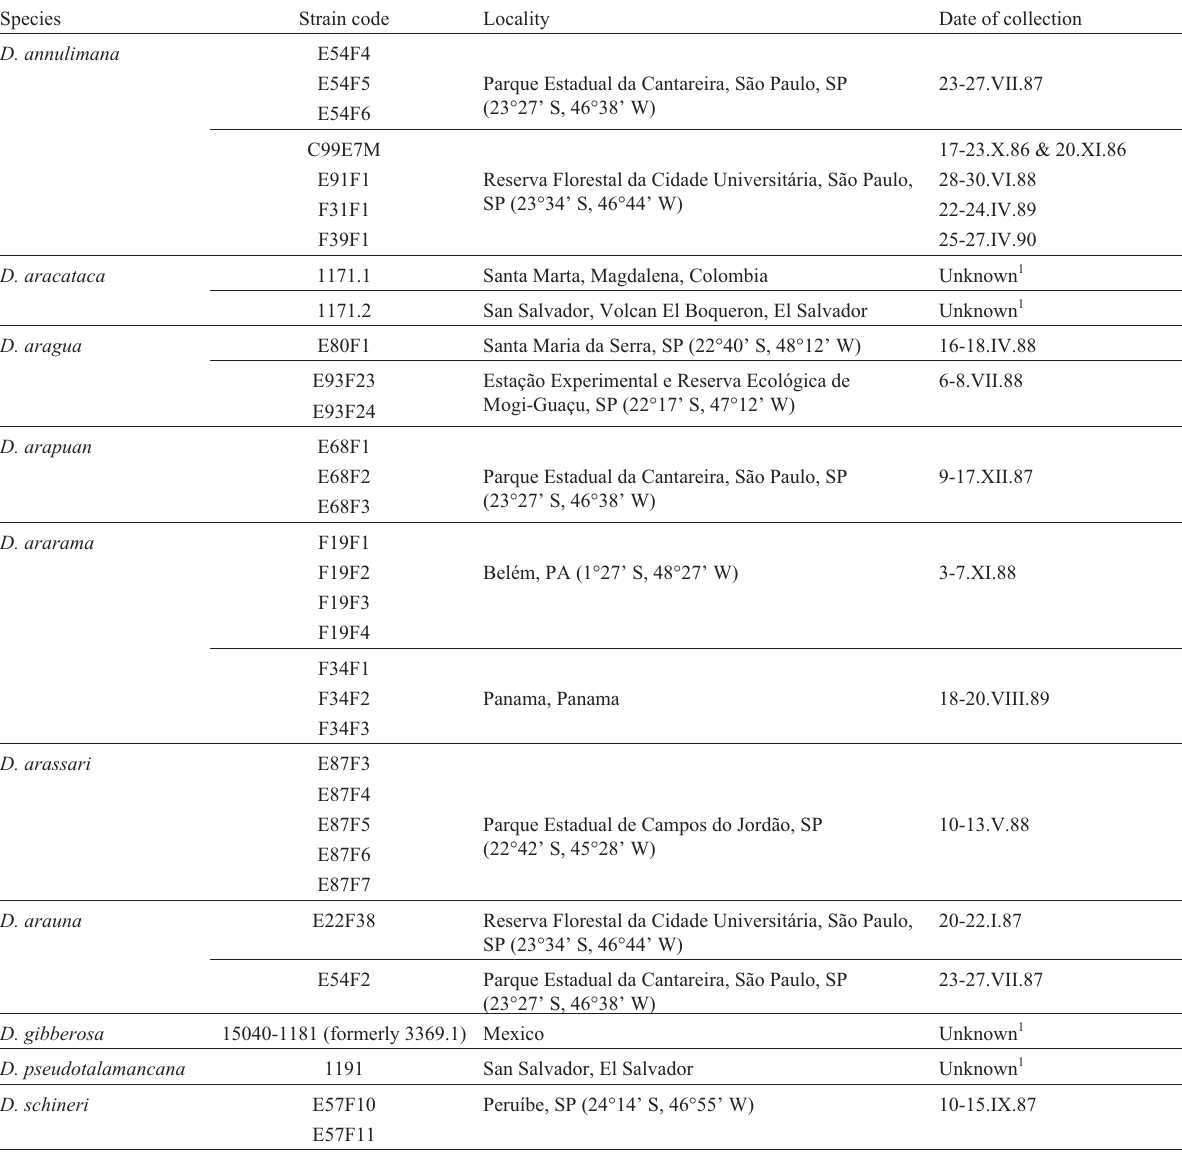
Table 1 - Collection sites and dates for the strains of the ten Drosophila species of the annulimana group analyzed. Species Strain code